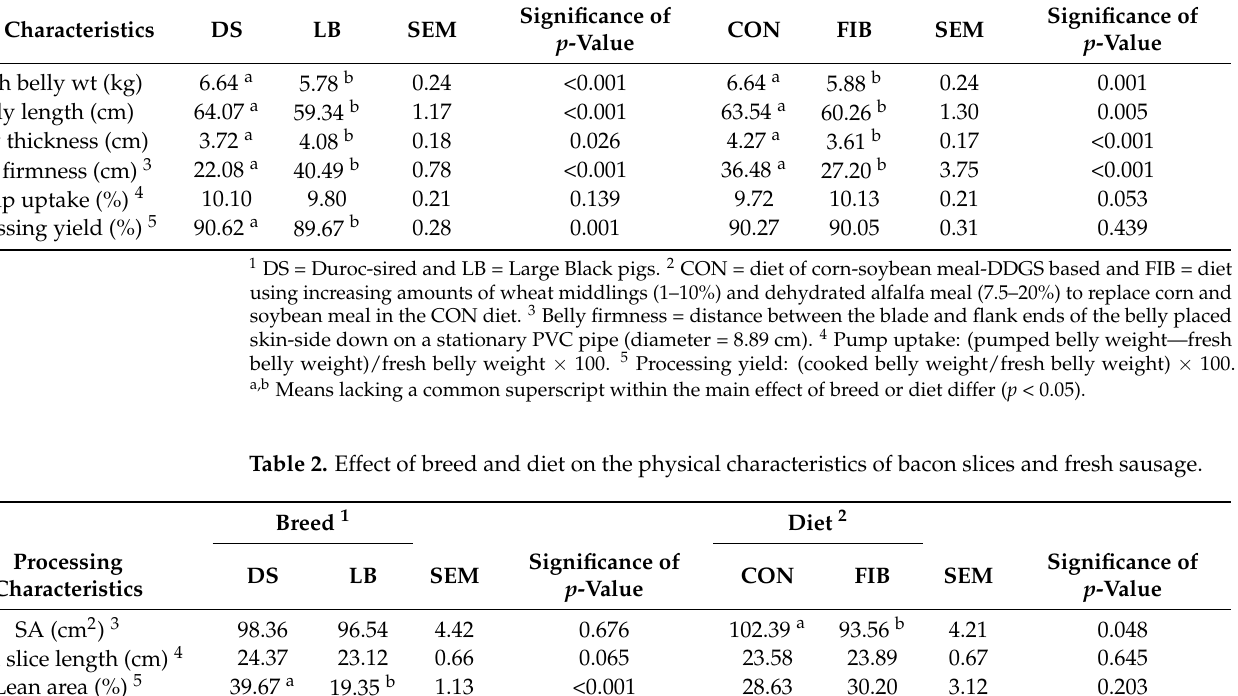
Table 1. Effect of breed and diet on fresh belly characteristics.